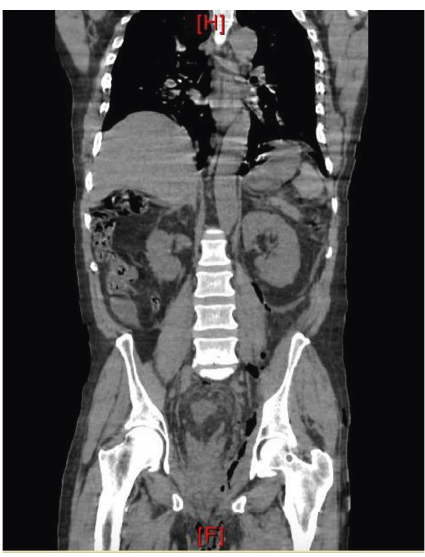
Figure 1: Coronal CT image showing gas tracking from left perirectal area superiorly into the left retroperitoneum to the level of the medial and inferior left kidney.